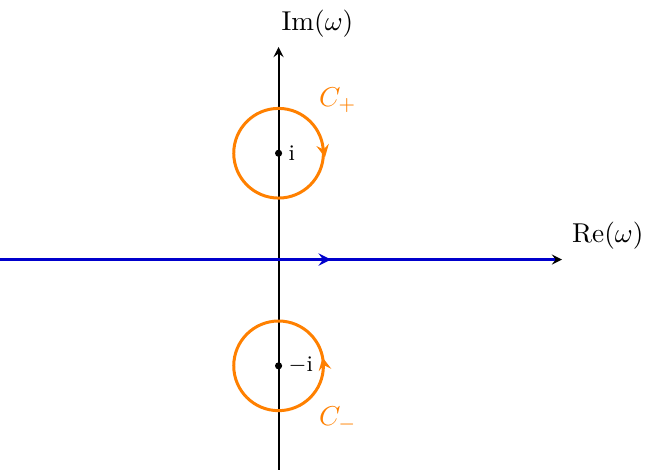
Figure 2 . The contours for the Green’s functions for the Dirichlet (the blue real line) and Neumann boundary conditions (the blue real line and two orange circles C